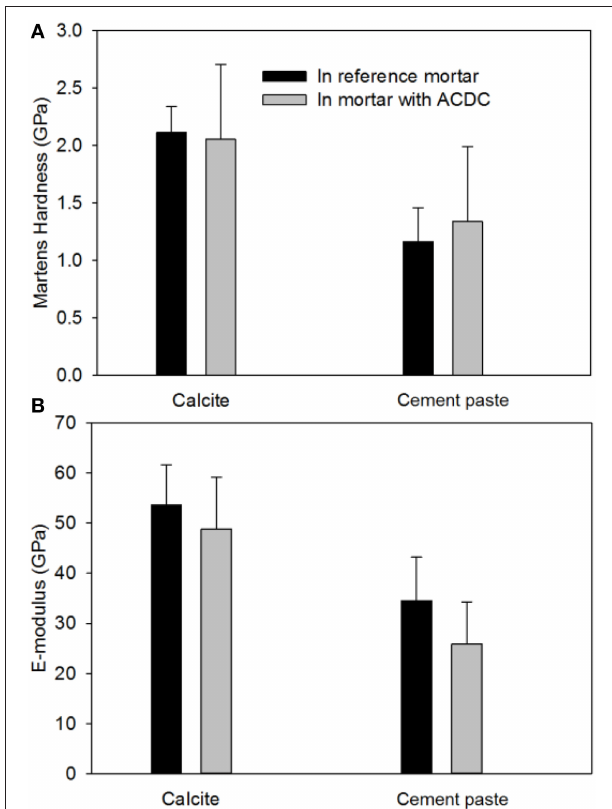
FIGURE 8 | Mechanical properties of the calcite and the cement paste found in autogenously and microbial healed specimens (A) Martens hardness values (B) calculated modulus of elasticity ( n ≥ 10 , error bars represent the standard